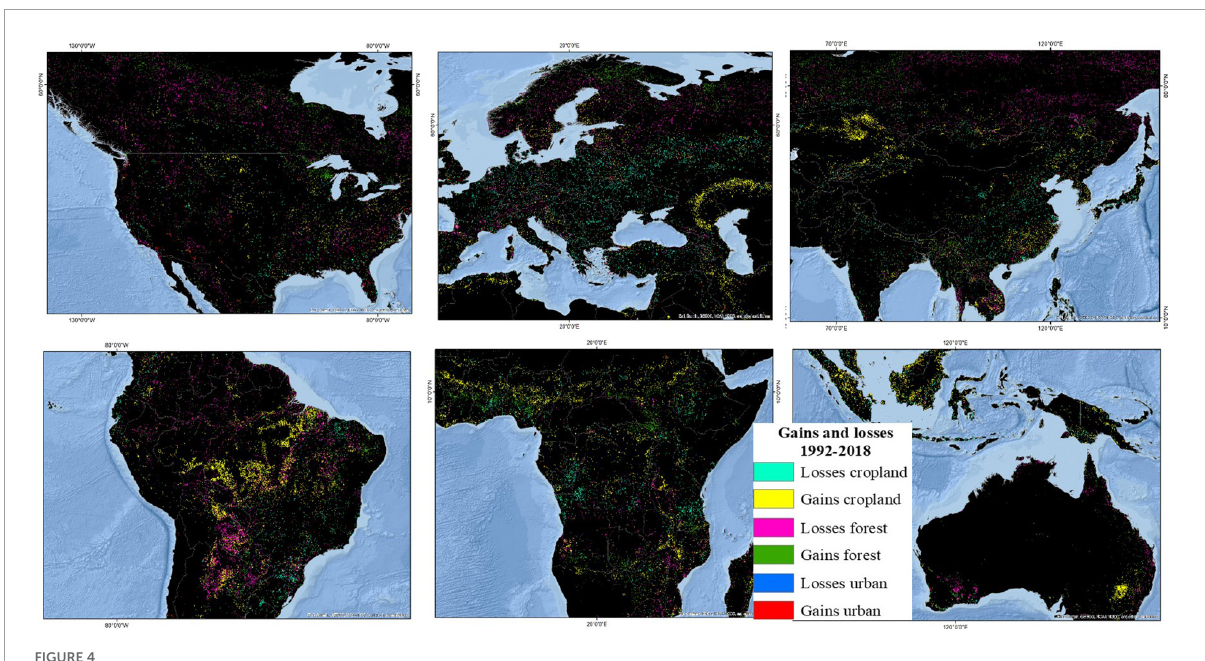
FIGURE4 Maps of the main land-cover type gains and losses between 1992 and 2018.